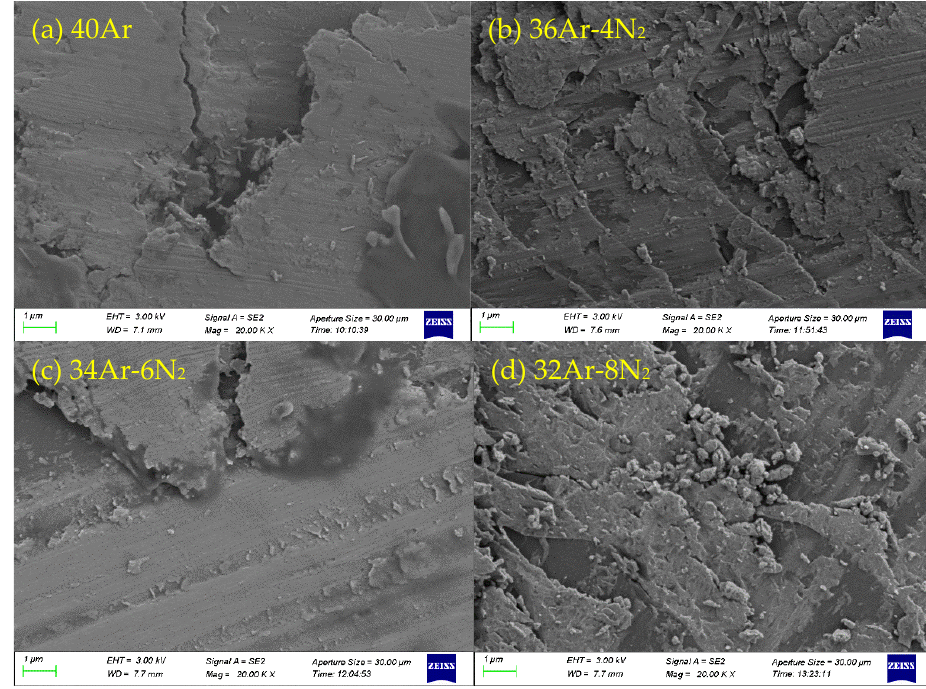
Figure 9. Wear debris morphology of Ta 2 O 5 coatings prepared under different sputtering gas conditions. ( a ) 40Ar, ( b ) 36Ar–4N 2 , ( c ) 34Ar–6N 2 , ( d ) 32Ar–8N 2.